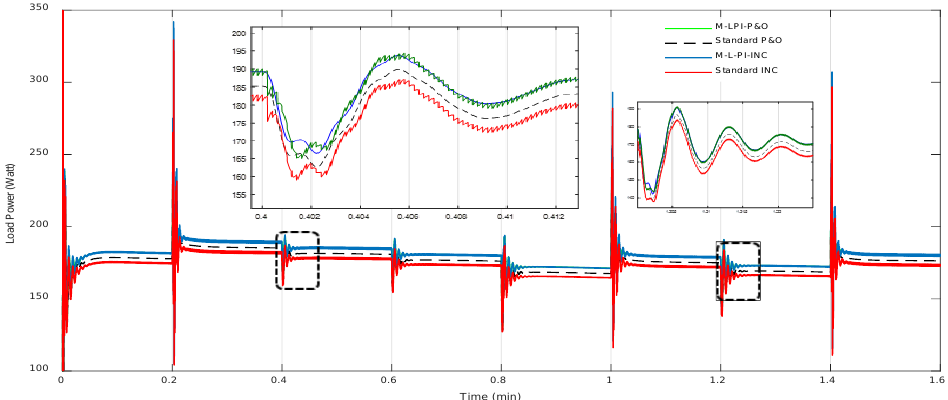
Figure 16. Transformed energy to the DC load at different solar irradiation.